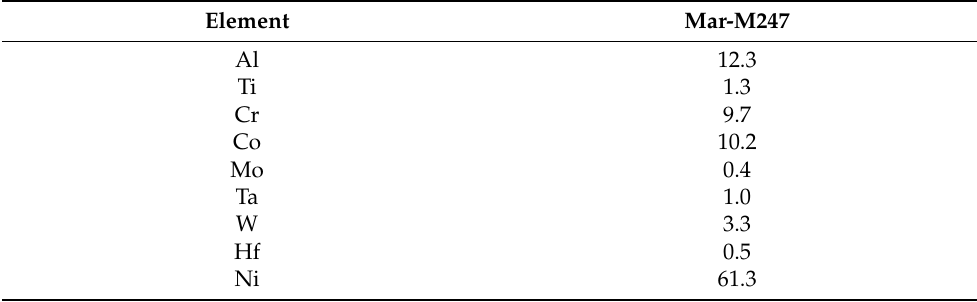
Table 1. Composition of Mar-M247 reference alloy in